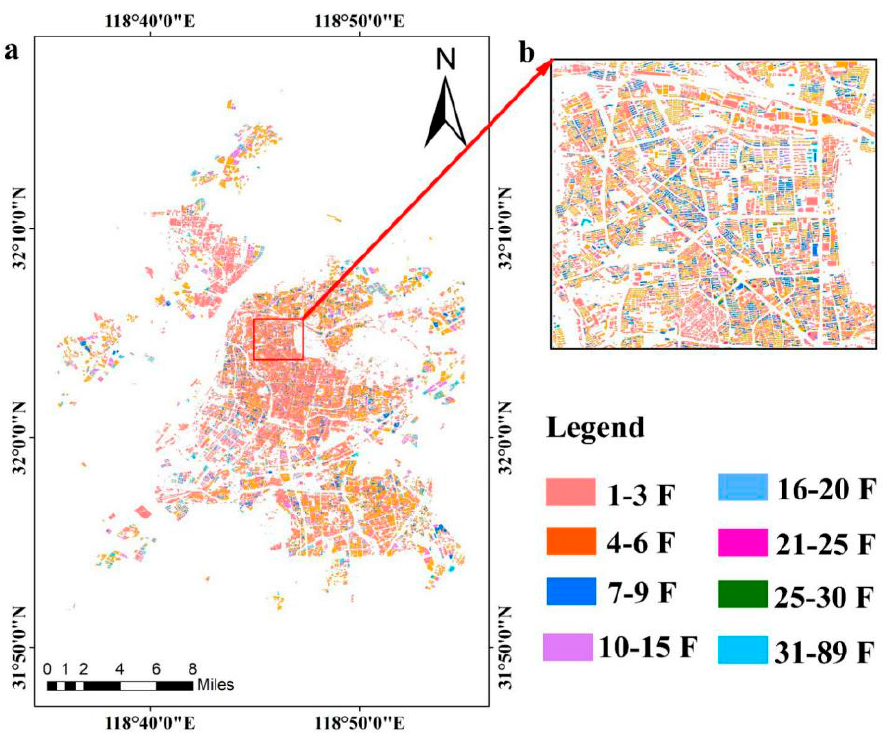
Figure 5. ( a ) The distribution of buildings with different height grades in Nanjing (the “F” in legend means floor). ( b ) A zoomed-in figure of the area in the red frame.